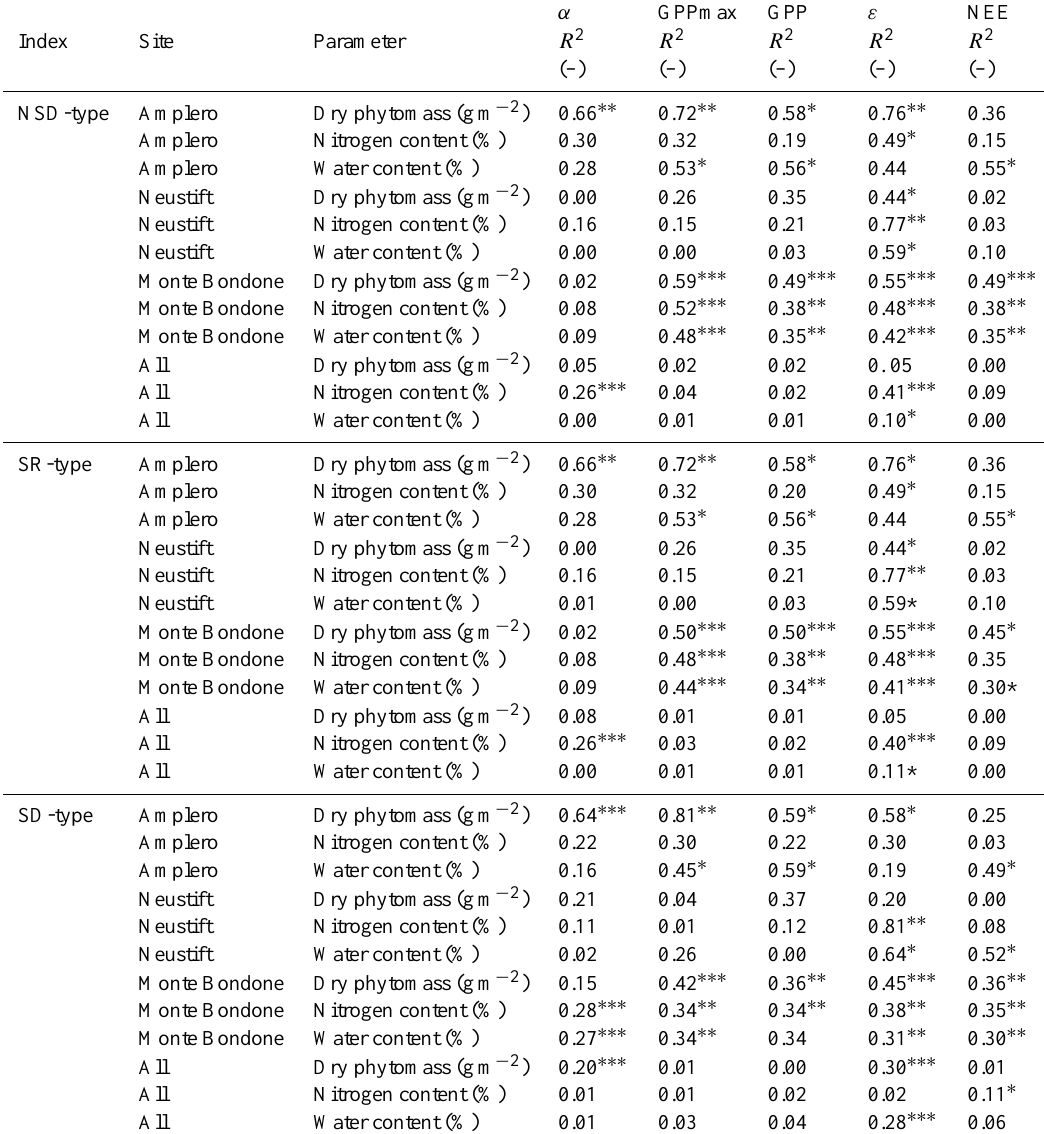
Table 5. Results of the correlation ( R 2 – coefficient of determination) between the best NDS-, SR- and SD-type indices selected for α , GPP max , midday GPP, midday ε and midday NEE and dry phytomass, nitrogen and water content for Amplero, Neustift, Monte Bondone and all sites pooled. The selected bands for computing NSD-, SR- and SD-type indices are reported in brackets. Statistical significance is indicated as ∗ ( p < 0 . 05), ∗∗ ( p < 0 . 01) and ∗∗∗ ( p < 0 .